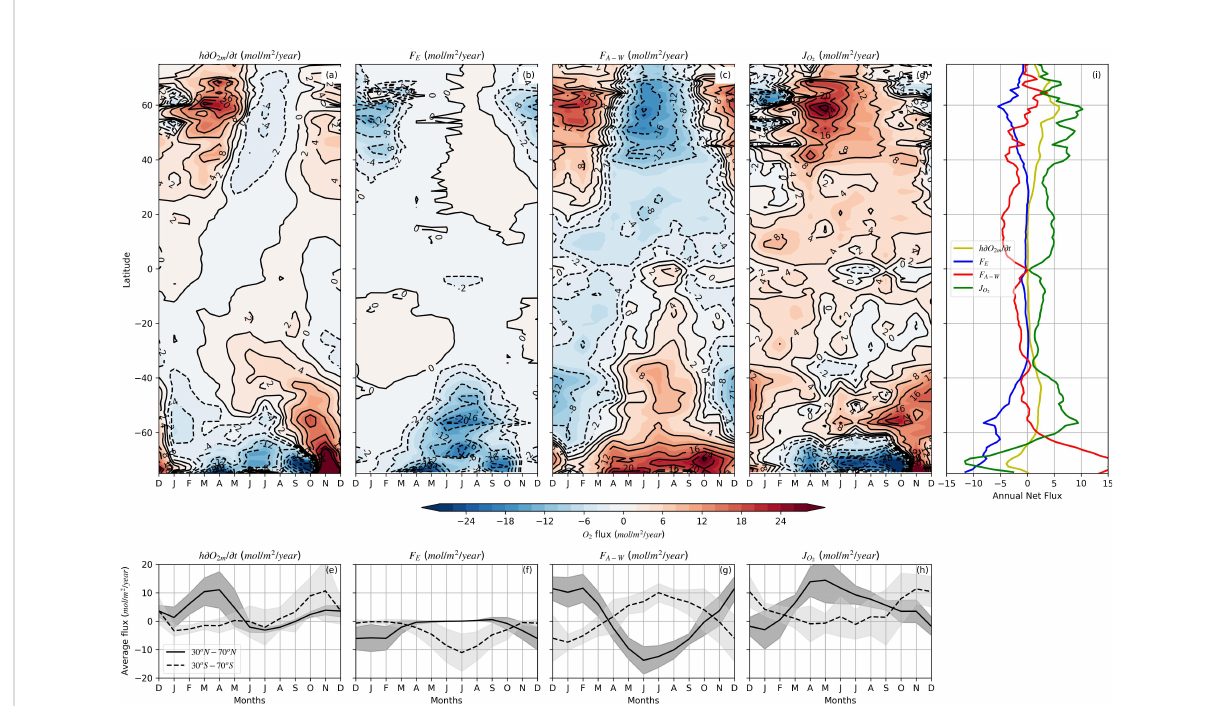
FIGURE 4 Zonally averaged mixed layer (A) oxygen content change, (B) entrainment, (C) air-sea O 2 fl ux and (D) residuals ( “ biological ” O 2 production). Same colorbar is used for panels (A – D) as shown below them. Monthly time series estimate between 30° and 70° for (E) oxygen content change, (F) entrainment, (G) air-sea O 2 fl ux and (H) “ biological ” O 2 production, respectively. (I) Annual zonally-averaged net O 2 fl ux (change) for the terms shown in (A – D) . The shadow areas in (E – H) represent the data variability (±1